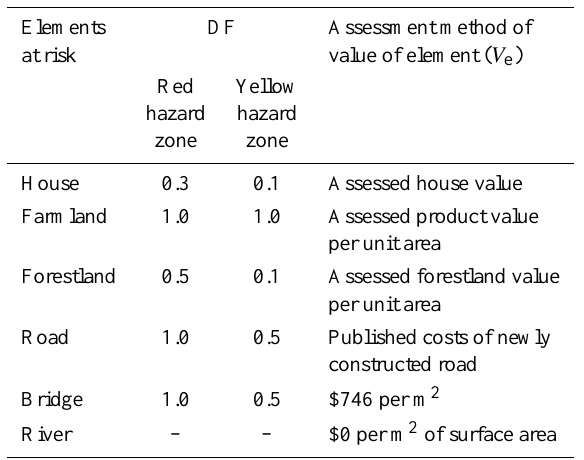
Table 2. Damage factors (DF) and assessment methods of elements at